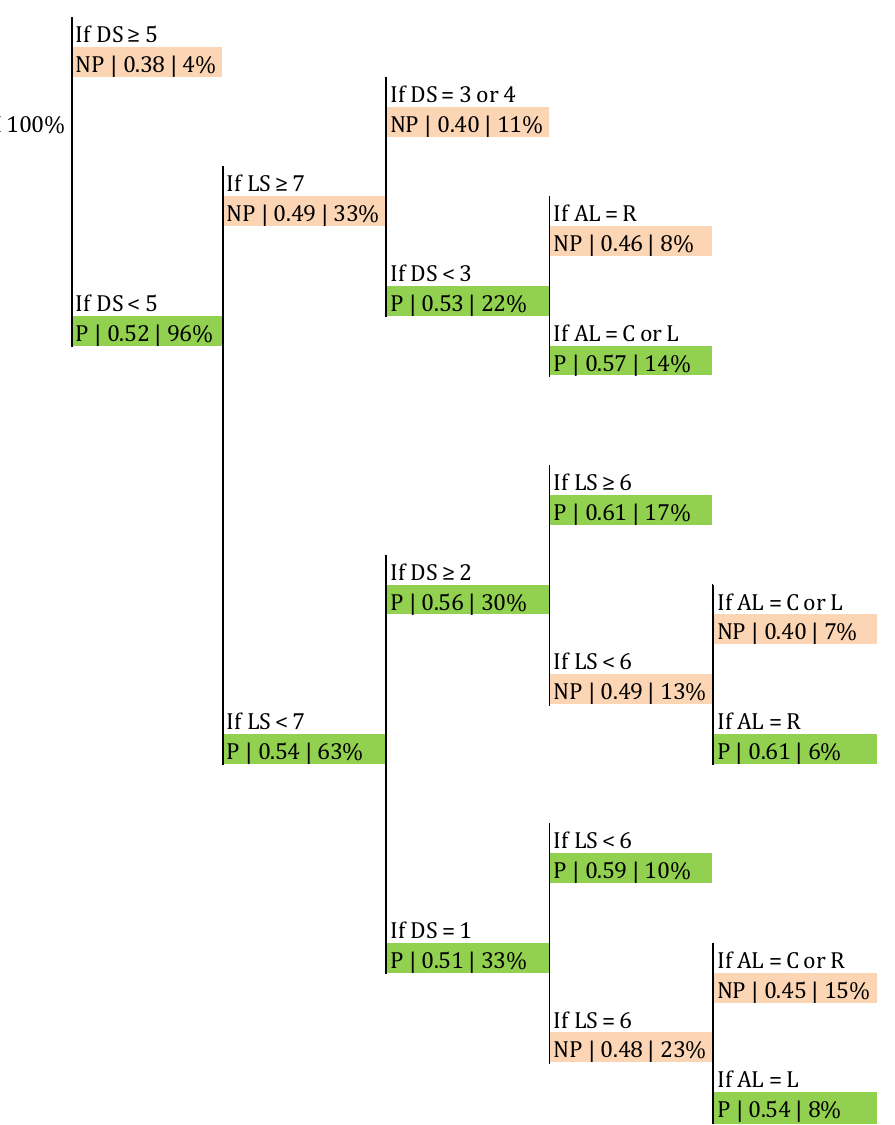
Figure 9. Probability of a point in the side-out depending on the attack lane, the LS, and DS; R: right attack lane; C: central attack lane; L: left attack lane.